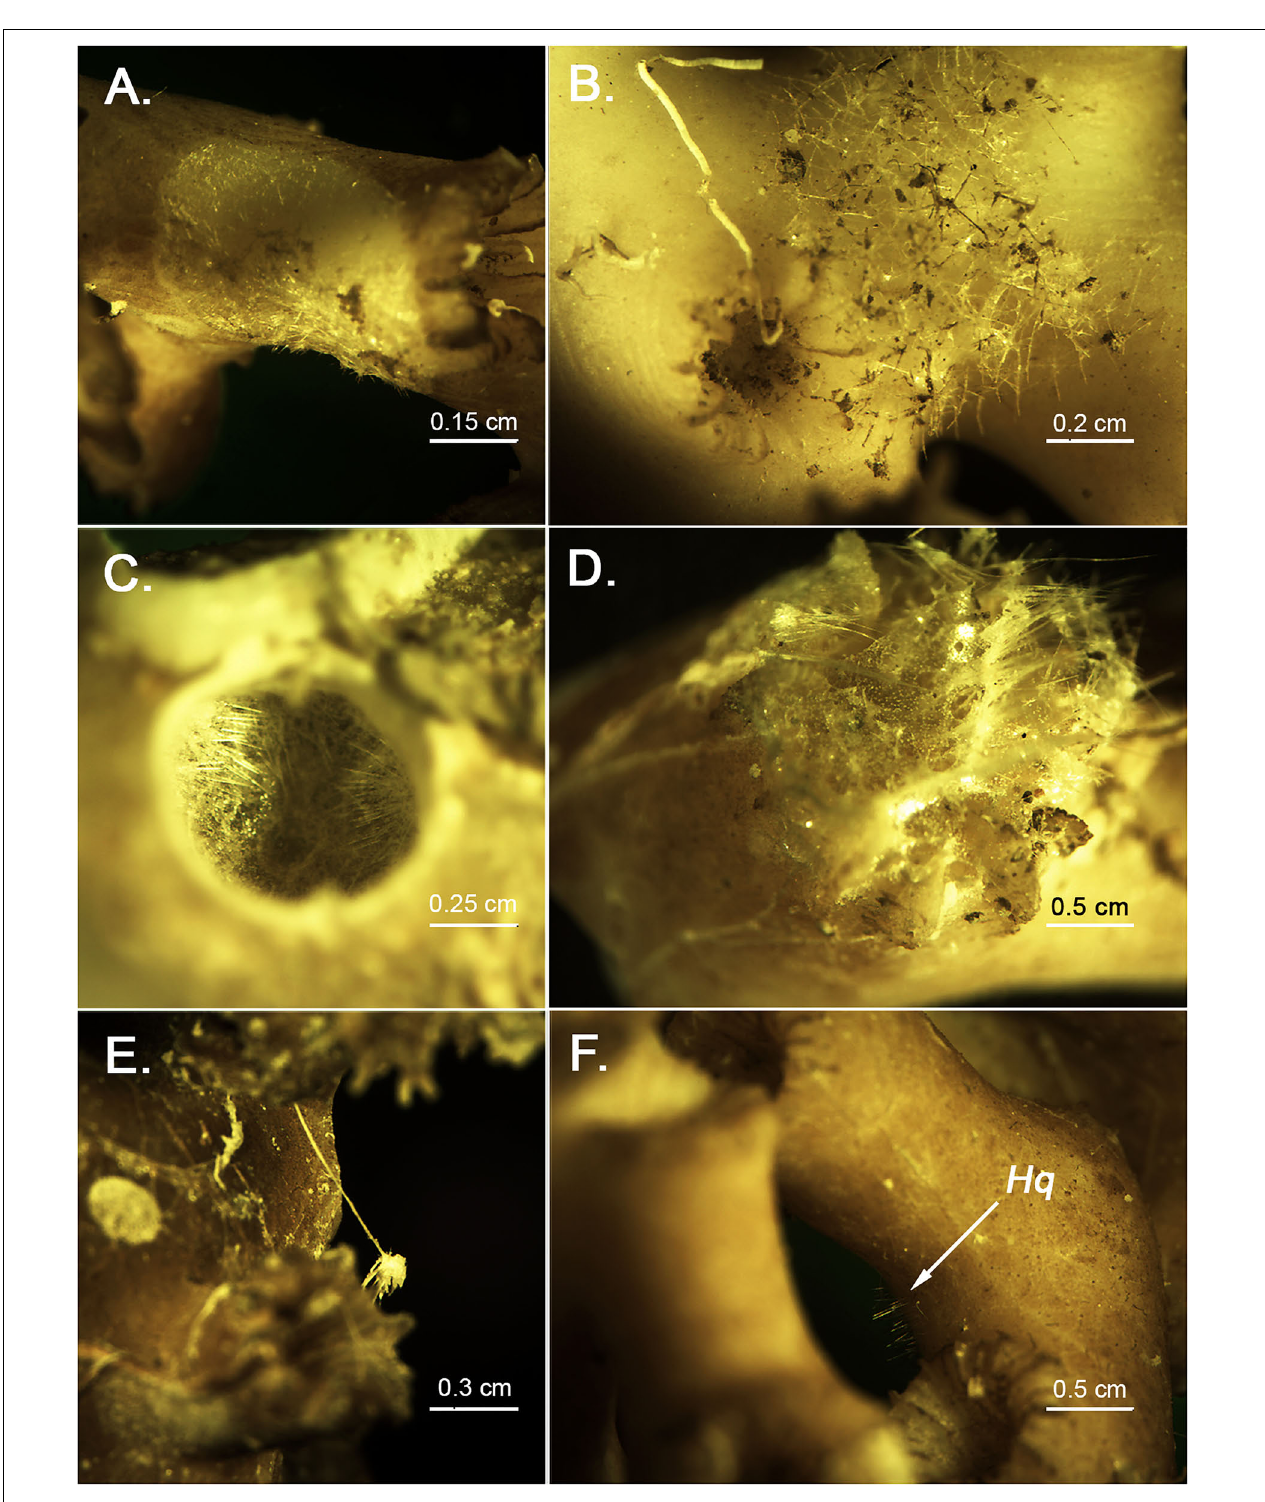
FIGURE 3 | Close up of several sponge species growing onto the Madrepora rubble (A) holotype of Hamacantha ( Hamacantha ) hortae sp. nov. (B) Individual of Tetrodictyum reiswigi . (C) Sphincter caused by the boring sponge Siphonodictyon infestum , known to erode the calcareous skeleton of several CWC species. (D) Poecillastra taviani individual growing inside a dead polyp. Interestingly enough, and despite the huge number of individuals encountered (over 70), practically all individuals dwelled exclusively inside the polyps, which might be interpreted as a niche preference for cavities and other burrows. (E) Individual of the carnivorous sponge Lycopodina hypogea , which had been previously recorded in the area associated with marine debris (Santín et al., 2020a). (F) Encrusting individual of Hymedesmia ( Hymedesmia ) quadridentata, with a clear hispidation visible to the naked eye.